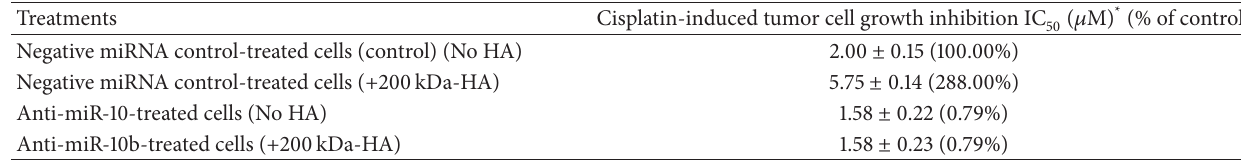
( 𝜇 M) * (% of control) 50